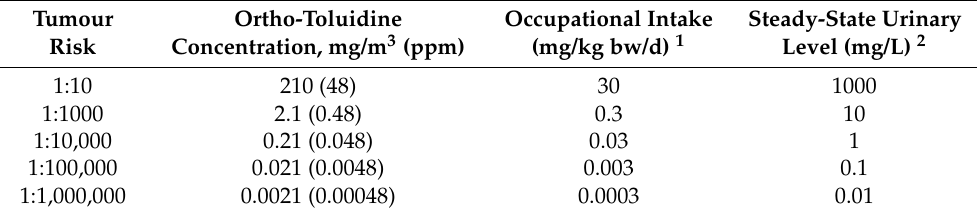
Table 2. Ortho-toluidine linear cancer risk estimations, corresponding to occupational exposure to specific air levels, calculated daily occupational intake, and calculated urinary steady-state levels.